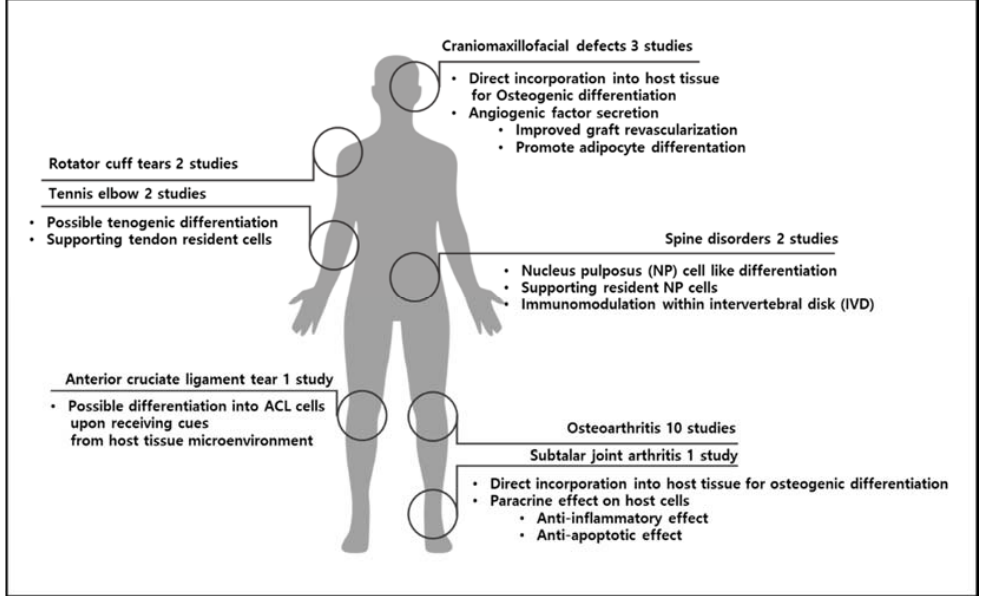
Figure 2. Summary of MSDs covered by this review and possible underlying mechanisms with which delivered ADSCs produce regenerative effects.